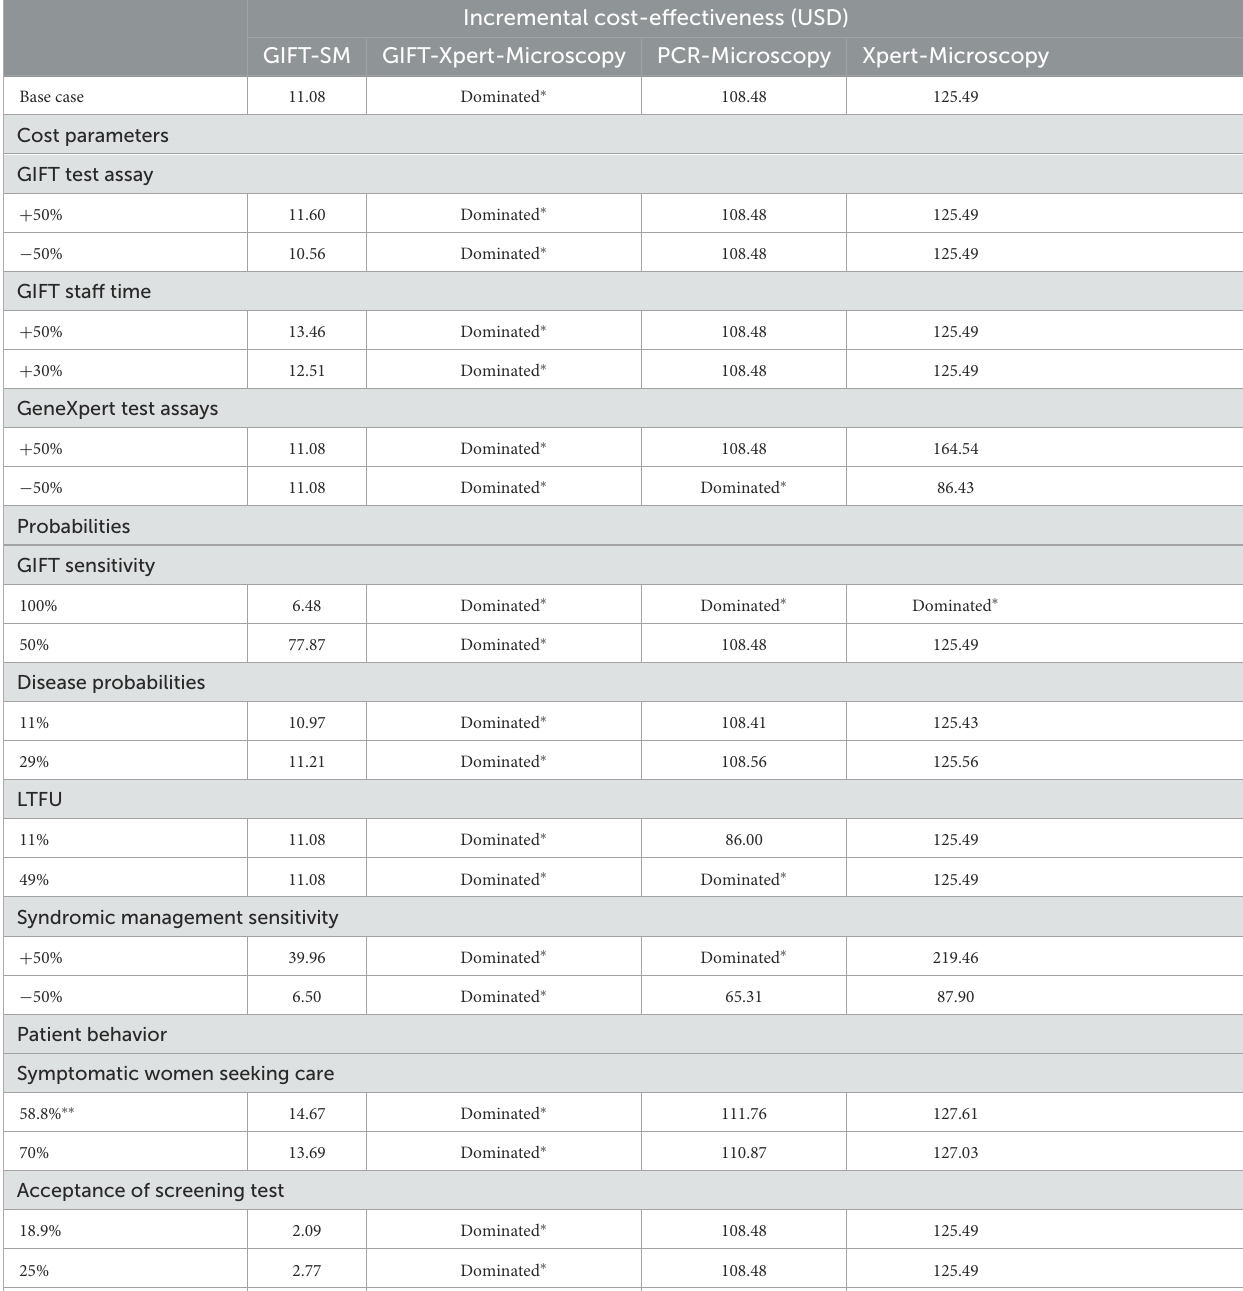
TABLE 5 The impact of one-way sensitivity analyses on the cost-effectiveness results in 2019 USD.